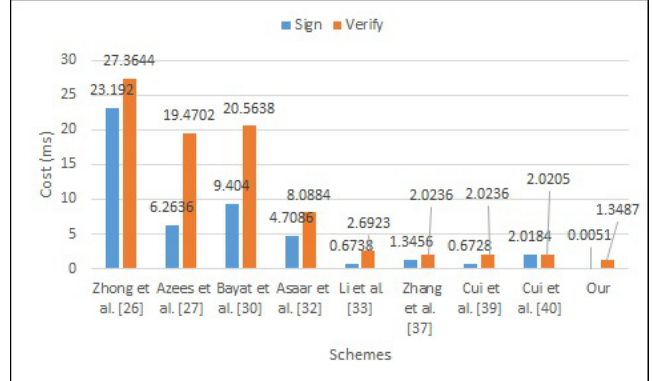
Figure 4. Computation cost for signing and verifying messages.